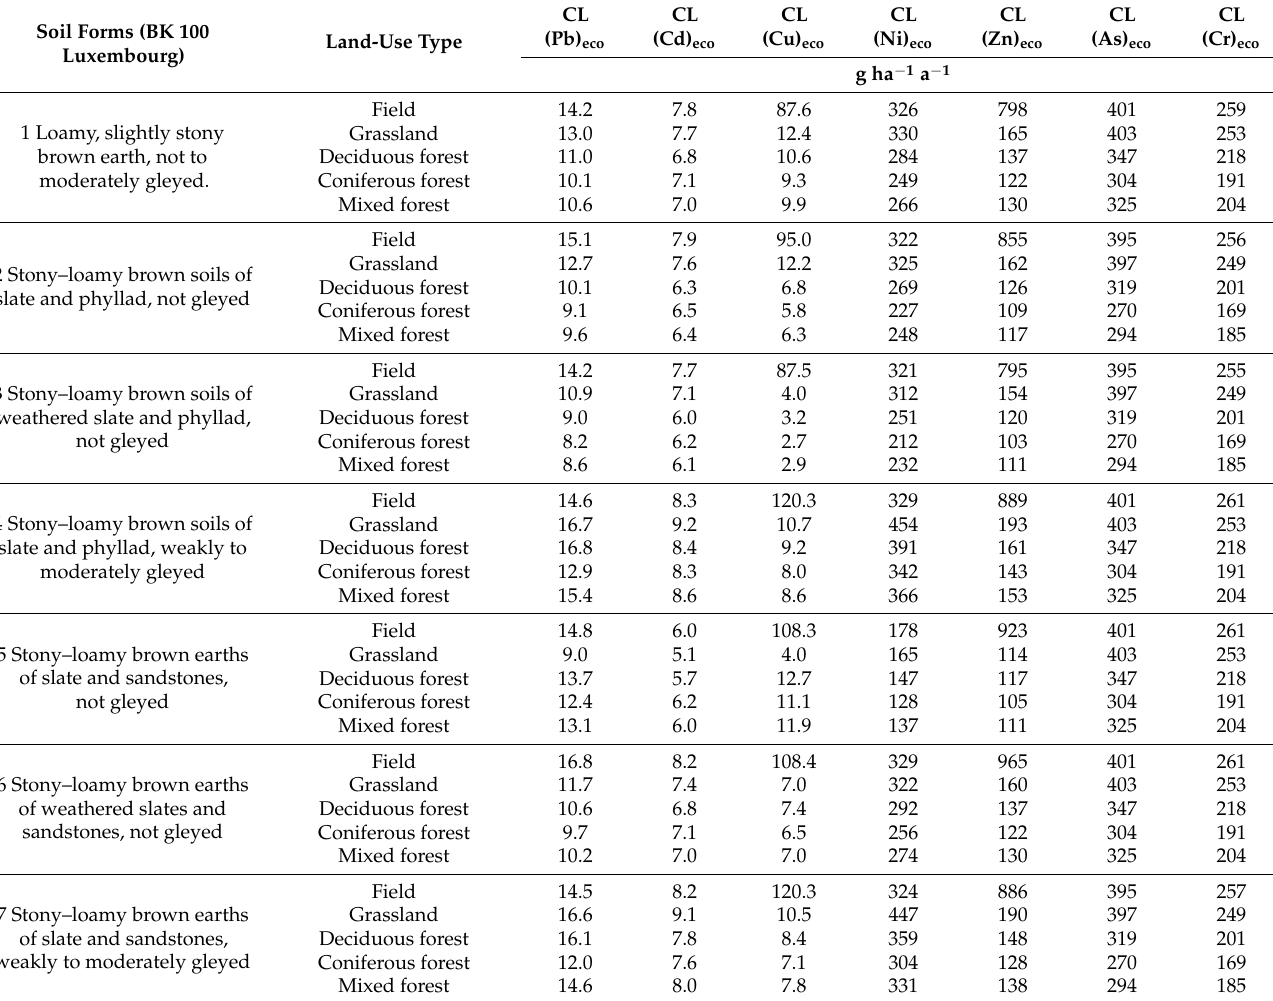
Table 19. Critical loads for the protection of plants, soil invertebrates and microorganisms for the different vegetation types in